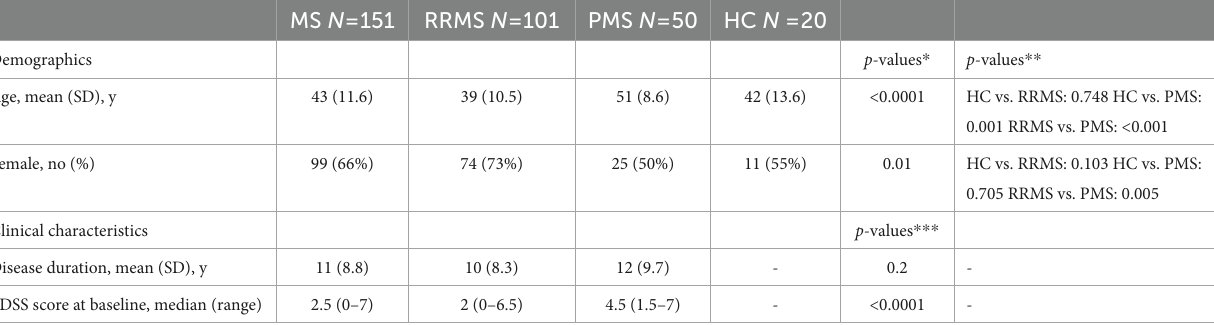
TABLE 1 Demographics and clinical